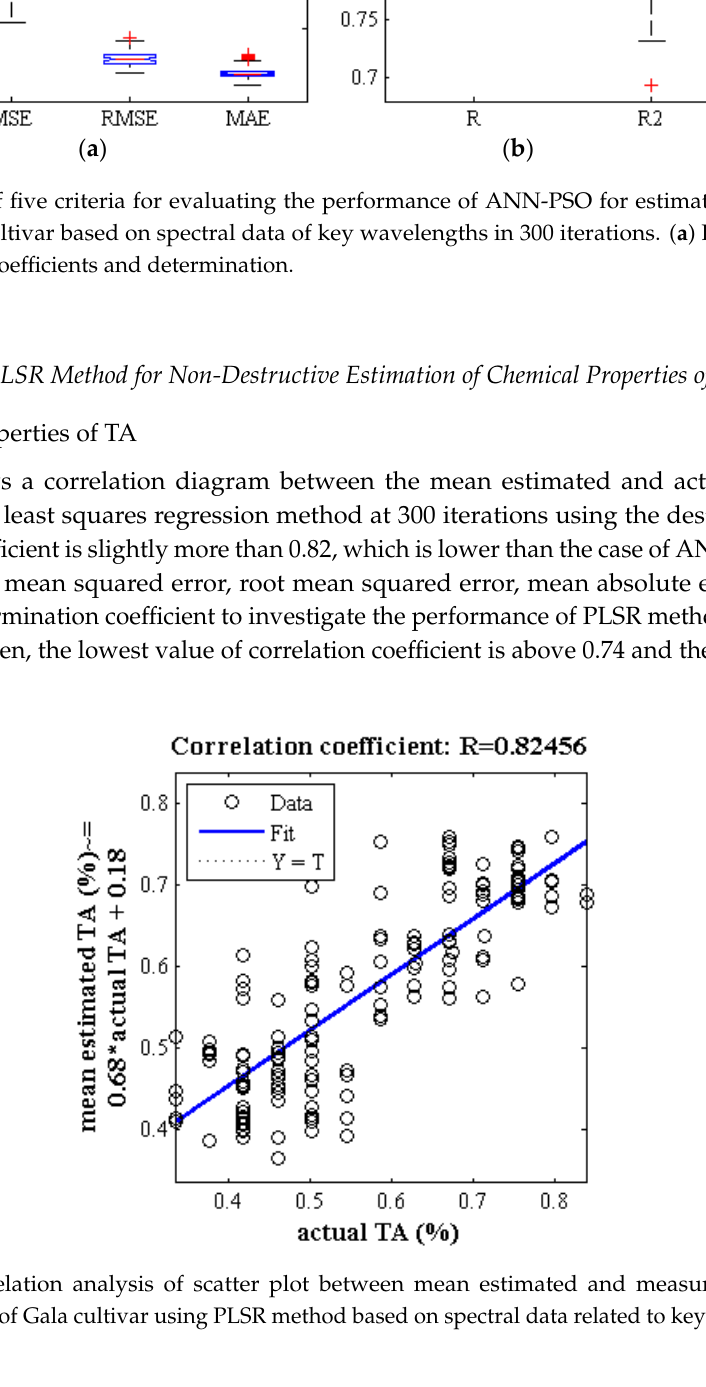
( b ) Figure 7. Box diagram of five criteria evaluating the performance of PLSR method for estimating the TA of Gala cultivar based on spectral data of key wavelengths in 300 iterations. ( a ) Error criteria, ( b ) Correlation coefficients and determination. 4.1.2. Chemical Properties of Taste Index Figure 8 illustrates the correlation analysis of the scatter plot between the mean estimated and measured taste index of Gala apple (test set) using PLSR method based on spectral data of key wavelengths in 300 iterations. As can be seen, the value of the correlation coefficient in this case is close to 0.85. Figure 9 shows a box diagram of the error criteria and correlation coefficients and determinations used to evaluate the performance of the PLSR method for estimating the taste index of Gala cultivar based on spectral data of key wavelengths at 300 iterations. The lowest coefficient of determination is 0.57 and the highest value is above 0.85.